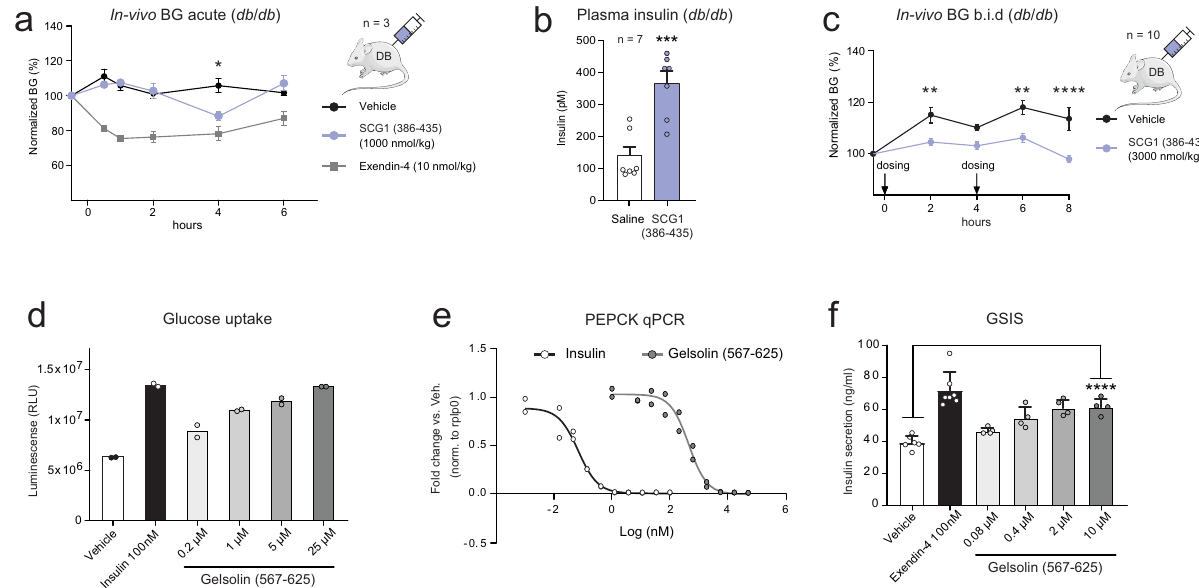
Fig. 8 | In-vitro and in-vivo assays reveals potential bioactive peptides. a BG mean values ± SEM in n=3 db/db mice after SCG1 peptide (NHPD-50, position 386 – 435) intraperitoneal injection at 1000nmol/kg. Exendin-4 at 10nmol/kg. Baseline normalized to 100%. Two-way ANOVA with post-hoc Dunnett ’ s test, P =0.022(4h). b Plasmainsulin(pmol/L)meanvalues±SEMin n =7 db/db mice6h after SCG1 peptide (NHPD-50) dosing at 2658nmol/kg. Unpaired two-sided t-test, P =0.0003. c BG mean values±SEM in n =10 db/db mice by twice daily SCG1 peptide (386 – 435) dosing at 3000nmol/kg. 8h of day 1 are shown. Two-way ANOVA, Sidak ’ s Multiple comparisons test, P =0.0055 (2h), P =0.0013 (6h), P <0.0001(8h). d Glucoseuptakein3T3-MBXcellsatday19. N =20,000cells/well in two independent biological experiments. Cells were treated overnight with